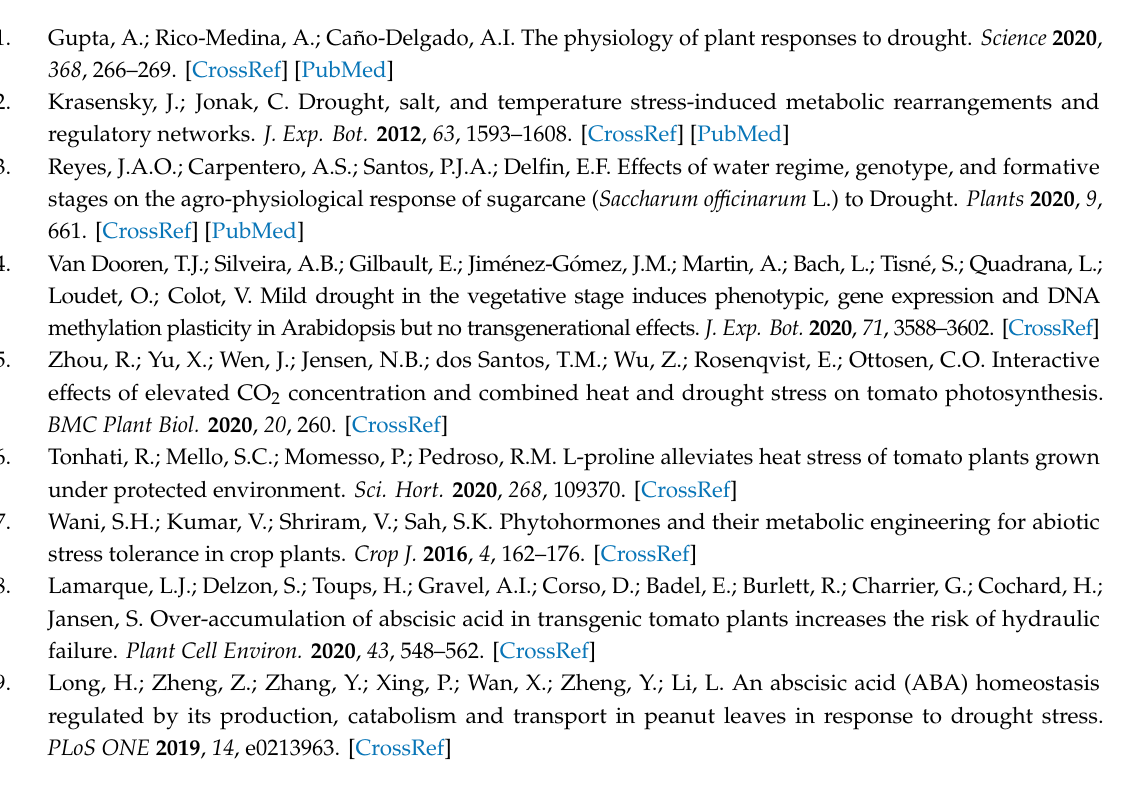
Table S1: Statistical analysis of the results (two-way ANOVA) to test the influence of the treatment (drought—D or recovery—R) and two genotypes (WT and flacca) and their interactions on the amount of ABA, stomatal conductance and relative water potential in tomato leaves. Table S2: Statistical analysis of the results (two-way ANOVA) to test the influence of the treatment (drought—D or recovery—R) and two genotypes (WT and flacca) and their interactions on the fresh and dry weight and the leaf area in tomato leaves. Table S3: Content of soluble sugars in the leaves of WT and flacca tomato genotypes subjected to six day water deficit (D) period followed by a six day period of re-watering (R). Table S4: Statistical analysis of the results (two-way ANOVA) to test the influence of the treatment (drought—D or recovery—R) and two genotypes (WT and flacca) and their interactions on the soluble sugars content. Table S5: Content of free amino acids (AAs) ( µ mol g − 1 FW) in the leaves of WT and Table S6: Statistical analysis of the results (two-way ANOVA) to test the influence of the treatment (drought—D or recovery—R) and two genotypes (WT and flacca) and their interactions on the free amino acids